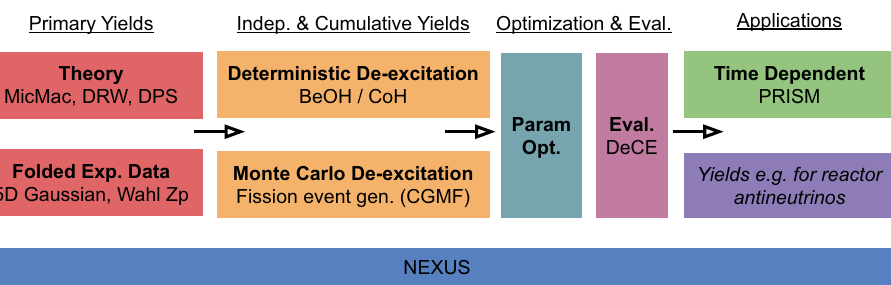
Figure 1. A schematic of some of the codes that comprise the Los Alamos fission evaluation pipeline. The workflow, indicated by arrows, is a combination of many distinct codes woven together by the Python3 framework, NEXUS . The creation of the evaluation file marks the beginning of public use for a variety of